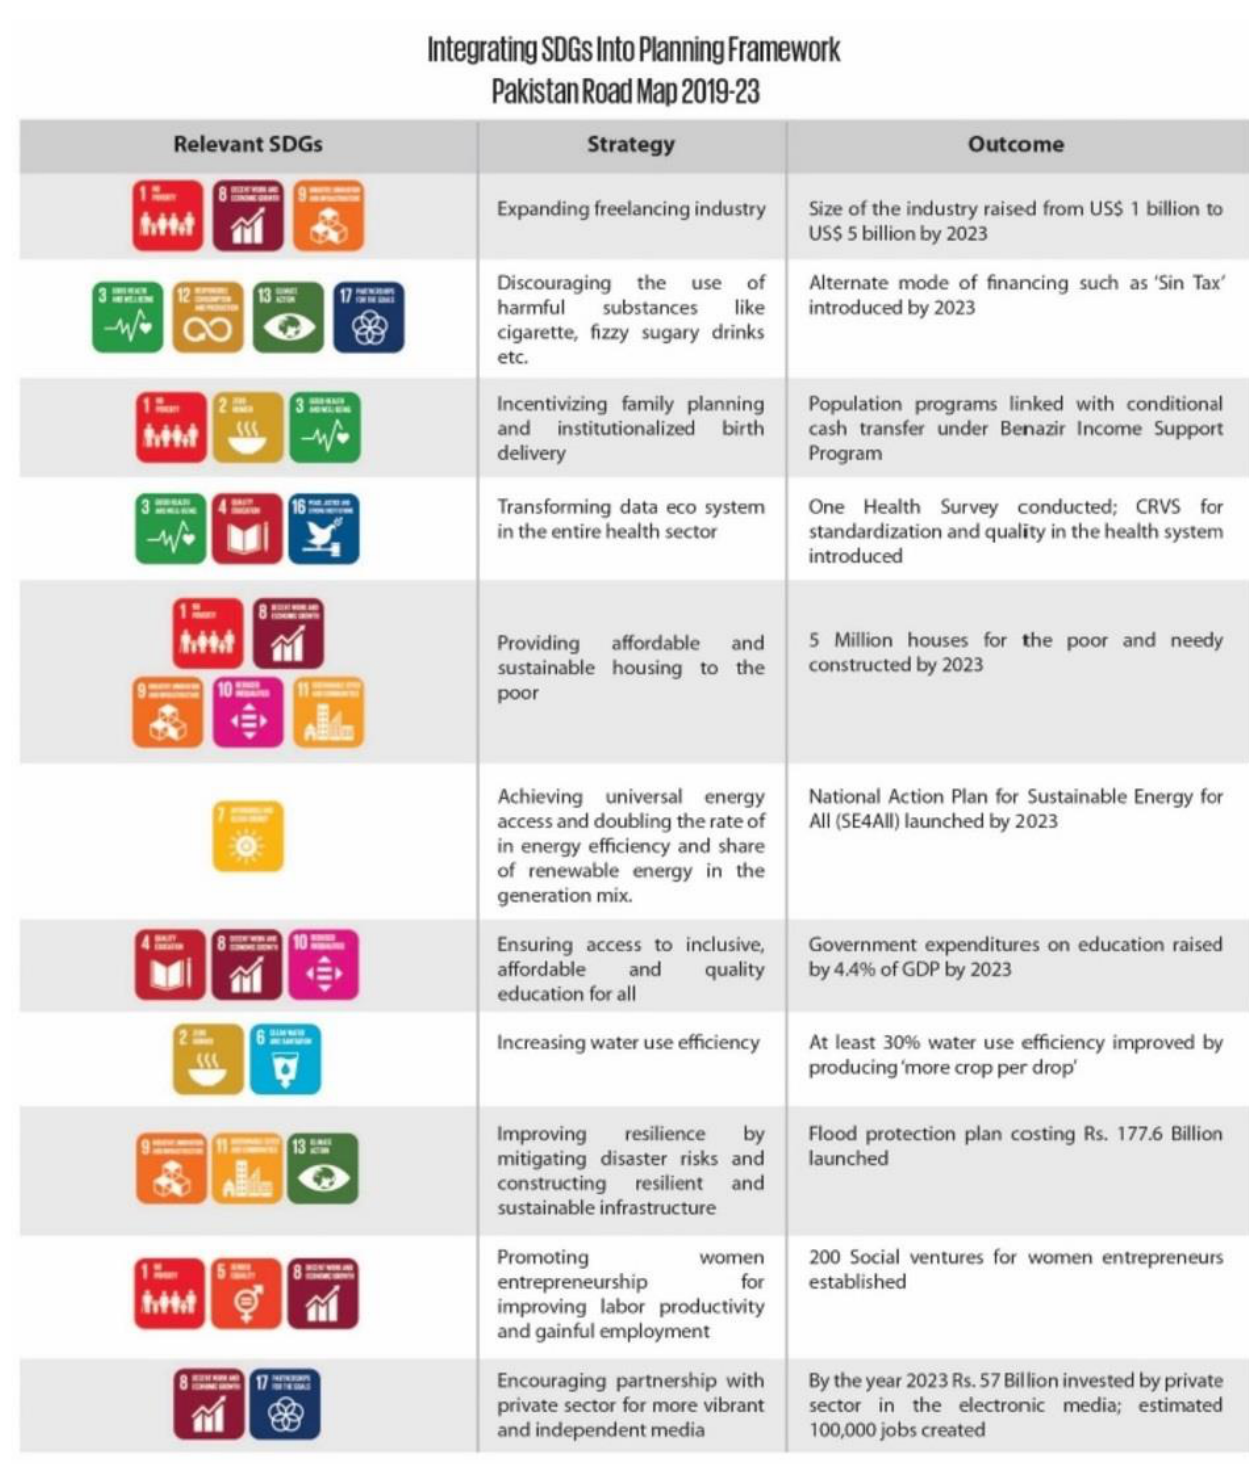
Figure 2. SDGPs framework for Pakistan.